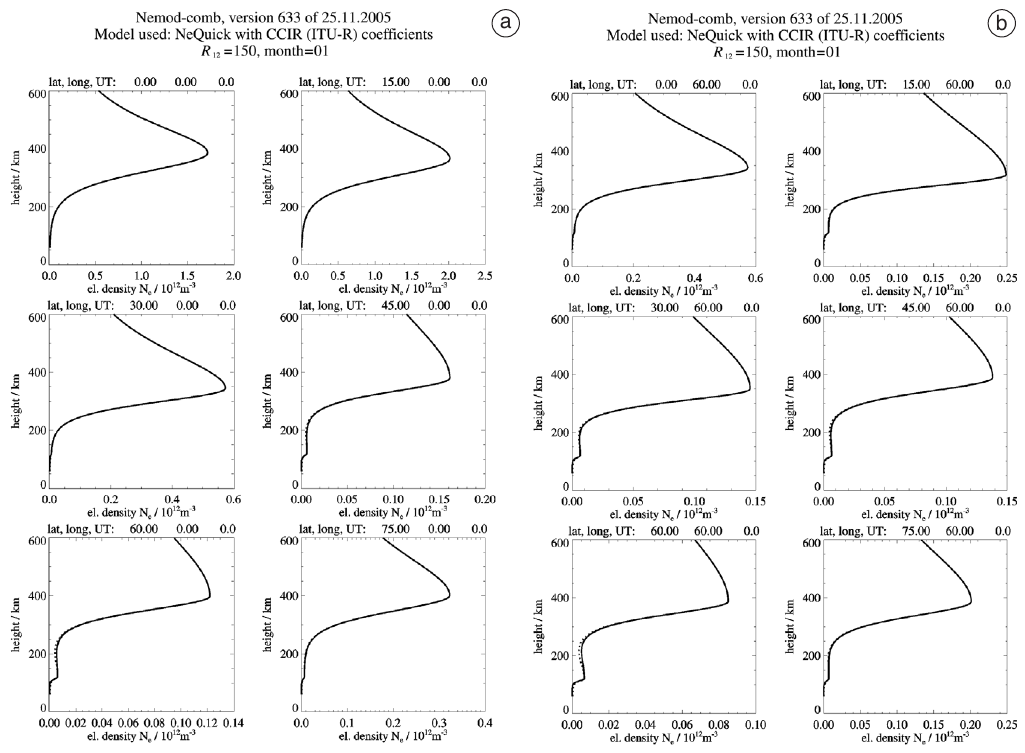
Fig. 3a,b. Height profiles of electron density: January; R 12 = 150; 0 h UT; geografic longitude 0°E (a), 60°E (b); 0 h LT (a), 4 h LT (b); geografic latitudes 0°N ( top left ) to 75°N ( bottom right ), latitude spacing 15°. Solid curves: revised NeQuick, dotted curves: NeQuick, old